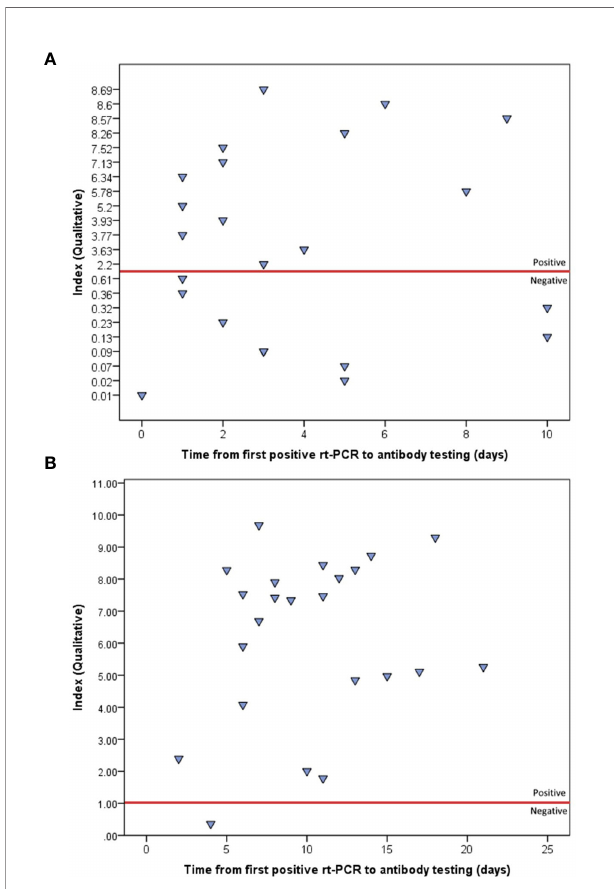
TABLE 1 | Demographic and clinical data of the participants.